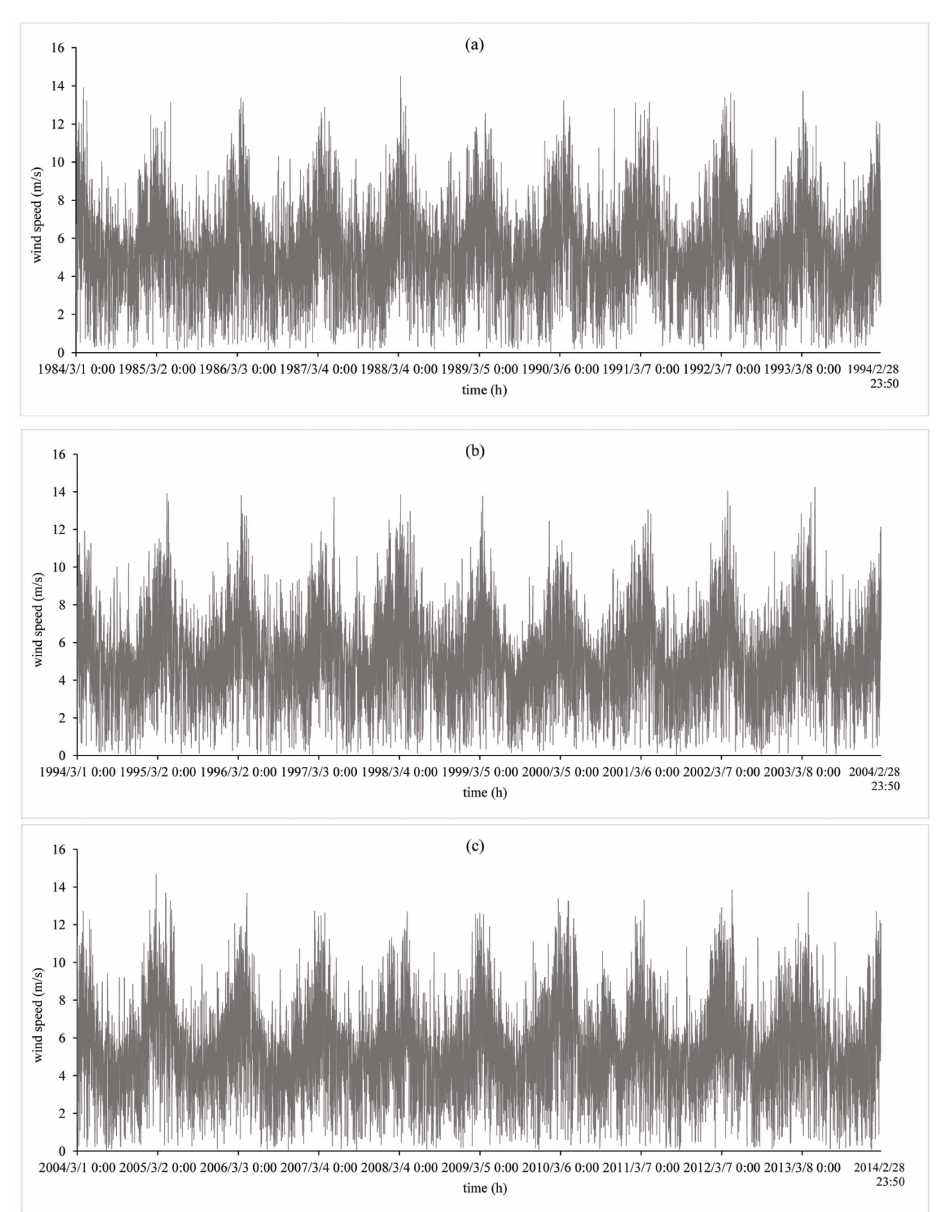
Figure 3. Wind speed process analyzed in this study. Data were downloaded using Modern-era Retrospective Analysis for Research and Applications [36], an application developed by NASA. Series covers Jinning region in southwestern China (24 ˝ 30 1 N, 102 ˝ 40.13 1 E) with resolution of 1 h and duration of 30 years (from 1 March 1984 0:00 to 28 February 2014 23:50). ( a ) The wind speed process from 1 March 1984 0:00 to 28 February 1994 23:50; ( b ) The wind speed process from 1March 1994 0:00 to 28 February 2004 23:50; ( c ) The wind speed process from 1 March 2004 0:00 to 28 February 2014 23:50. From Figures 2 and 3 it can be seen that both the runoff process and the wind speed process show periodical and random feature. During testing, different magnifications were adopted to obtain similar processes with different but regular fluctuation, such as abscissa zoom, ordinate zoom, and combinations of abscissa and ordinate zoom. Moreover, repeating disposal and superimposed disposal were applied. With various processes, the capability of the proposed index can be